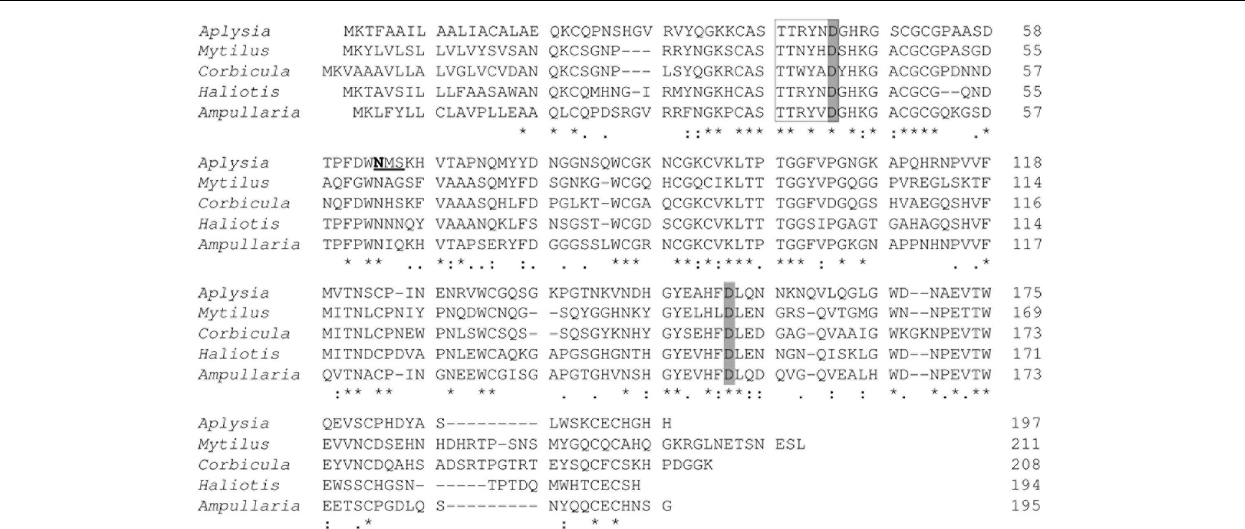
A. crossean (DDBJ accession number, EF471315). Identical, highly conservative, and conservative residues among sequences are indicated by asterisk ( ∗ ), colon (:), dot (.), respectively. The consensus amino-acid sequence and residues in catalytic sites of GHF45 cellulases are boxed and shaded, respectively. The putative N-glycosylation site is underlined and N-glycosylated residue is indicated with bold